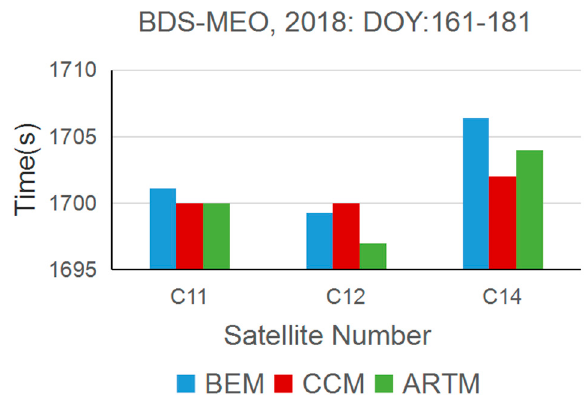
Figure 8. The mean shift time for BDS MEO satellites calculated by the three methods during DOY: 161–181, 2018.